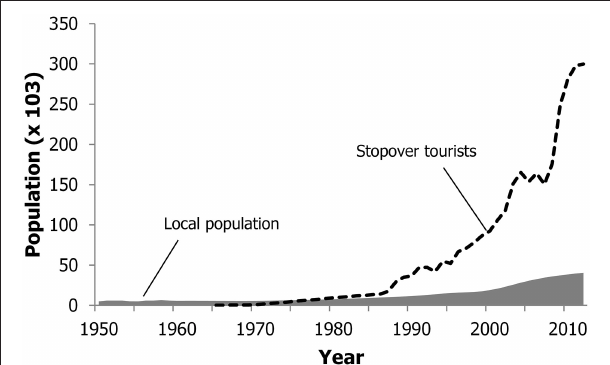
FIGURE 2 | Local and stop-over tourist population of the TCI, 1950–2012. Sources: (Bryden, 1973), 1962 anchor point; Caribbean Tourism Organization, 1980–2006 data; Turks and Caicos Islands Tour Board Statistics, 2007–2012 data. Note: stopover tourists average between 6 and 7 days each, and tourist-days were used to calculate